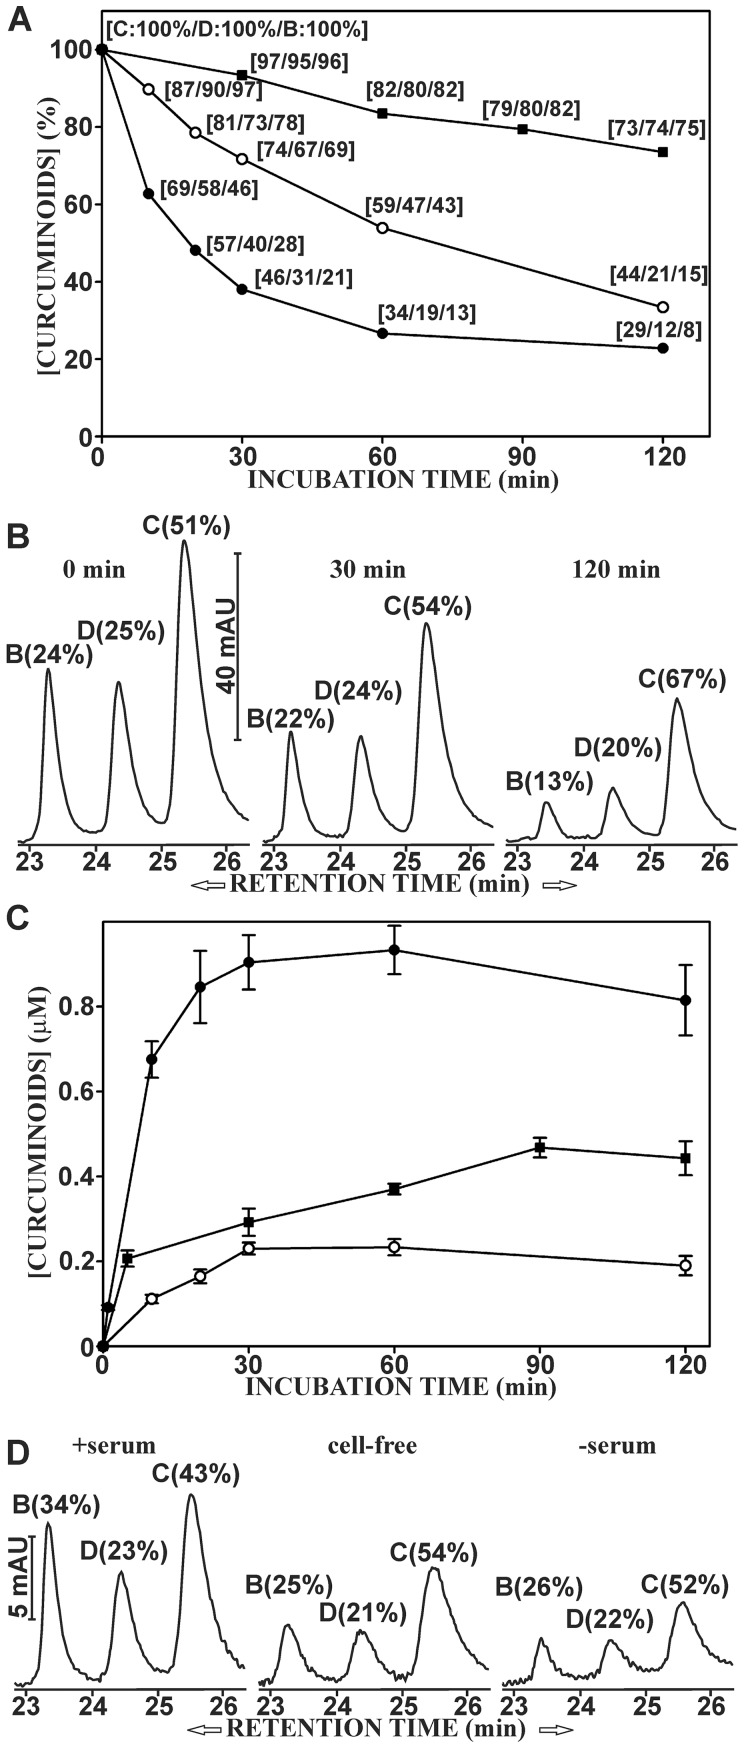
The dissociation of curcuminoids from NT2/D1 cells.(A). Cells were incubated with media containing 47 µM curcuminoids (SOLID+DMSO) for 1 h. The media were then removed and the cells washed. Cells were then incubated either with 2 ml of DMEM alone (○) or DMEM +5% FCS (•). Alternatively, cells were hypotonically lysed and incubated with 2 ml of 10 mM hepes, pH 6.8 (▪). The amount of curcuminoids bound to cells was then measured during a 2 h period. The numbers in brackets represent amounts of CUR (C), DMC (D) and BDMC (B) relative to their respective starting concentrations (100%). The values represent the average of three independent experiments with standard deviations ranging from 3–8% (error bars omitted). (B) Elution profiles of curcuminoids bound to cells at the start of incubation (0 min) and after 30 and 120 min. The numbers in parentheses indicate relative molar amounts of curcuminoids bound. (C) The concentrations of curcuminoids released into the media after incubation as described in A. (D) Elution profiles of curcuminoids in media after 30 min of incubation in DMEM alone (-serum), in DMEM with 5% FCS (+serum) and in 10 mM hepes, pH 6.8 (cell-free).